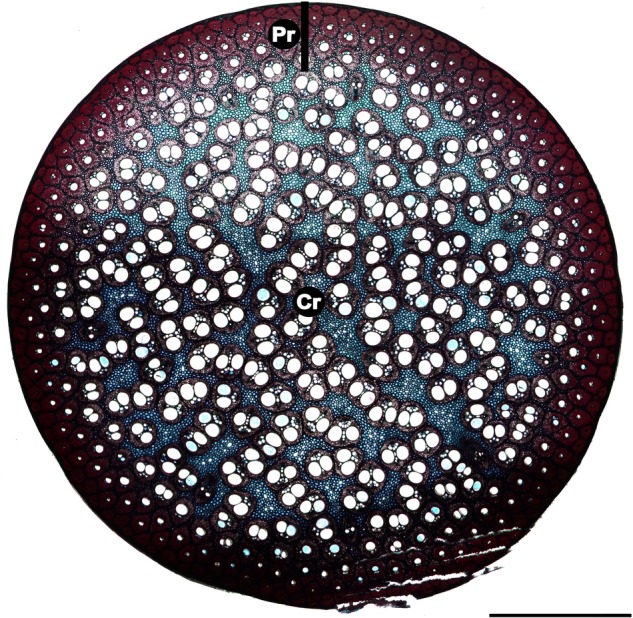
Transverse section of F. indica, without the leaf sheath. The stem is differentiated into two areas with specific anatomical characteristics. The region towards the periphery shows an increased number of vascular bundles and density of the bundle sheath. The central region shows a typical monocot stem anatomy, with scattered vascular bundles surrounded by parenchyma. Pr, peripheral region; Cr, central region. Scale bar is 2 mm.